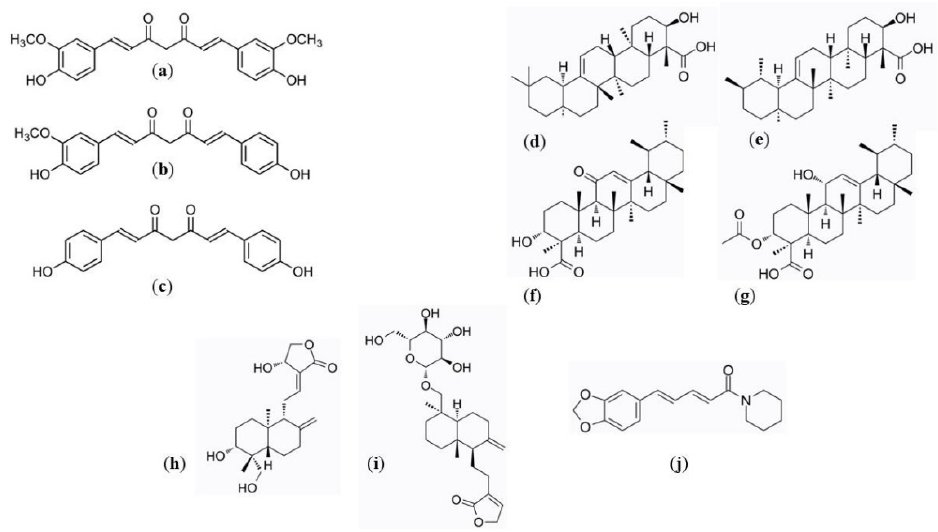
Figure 1. Chemical structures of curcuminoids (curcumin ( a ), demetoxycurcumin ( b ) and bisdeme- toxycurcumin ( c )), boswellic acids ( α -boswellic acid ( d ), β -boswellic acid ( e ), 11-keto- β -boswellic acid ( f ) and 3-acetyl-11-keto- β -boswellic acid ( g )), andrographolides (andrographolide ( h ) and neo- andrographolide ( i )) and piperine ( j ).